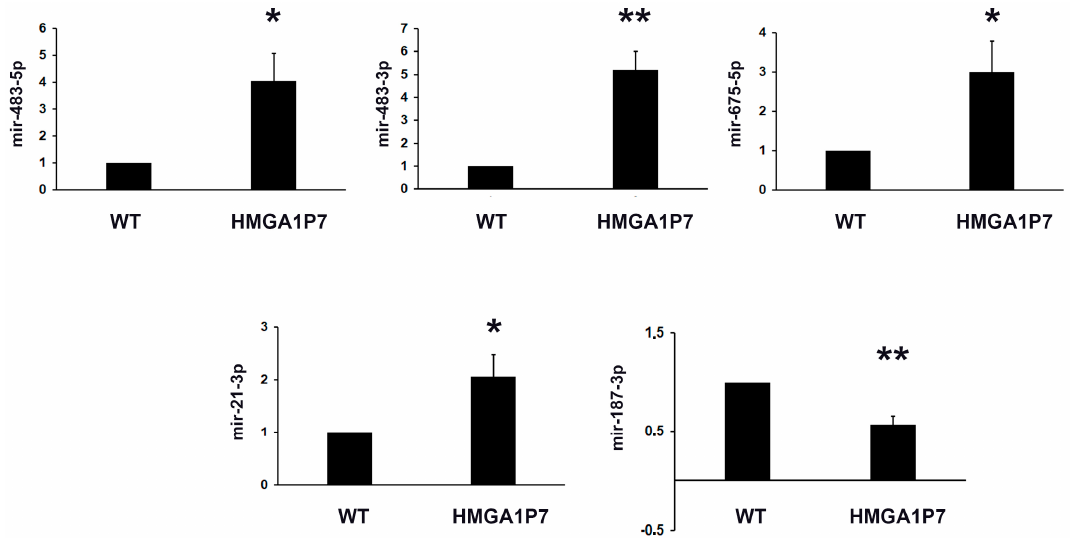
Figure 1. Validation of miRNA-seq data by qRT-PCR. qRT-PCR analysis of miR-483, miR-483-3p, miR-675-5p, miR-21-3p, and miR-187-3p in mouse embryonic fibroblasts (MEFs) from HMGA1P7 transgenic mice compared to wild-type (WT), set equal to 1. The results are reported as the mean of values. The error bars represent mean ± SD; *: p < 0.05, **: p < 0.01 (t test).